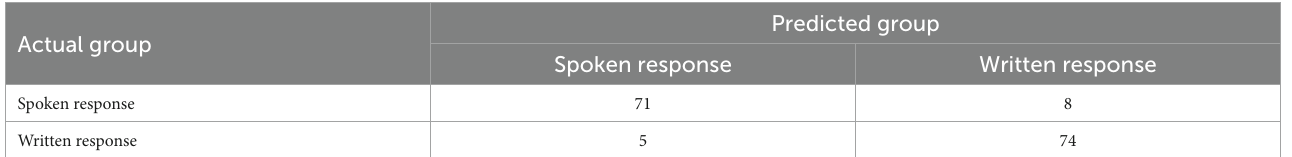
TABLE 5 Confusion matrix for classifying writing and speaking in the test set.